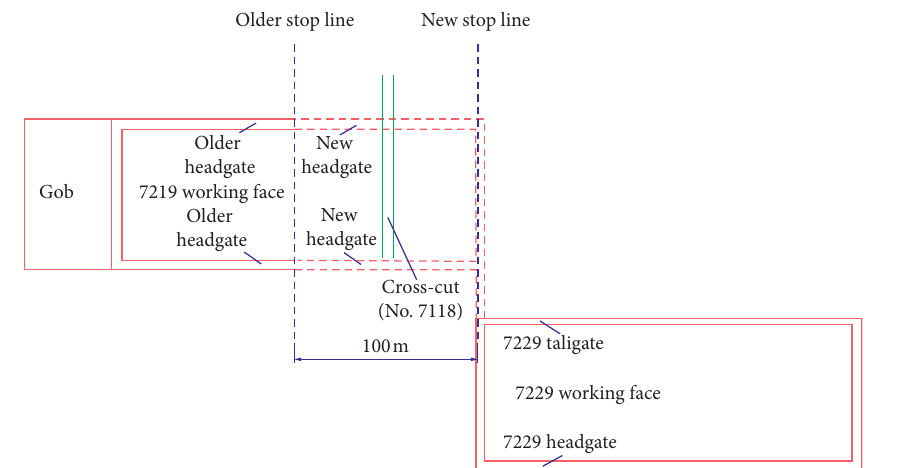
Figure 6: Positional relationship between the working faces and Table 1: Physical and mechanical properties of main floor.